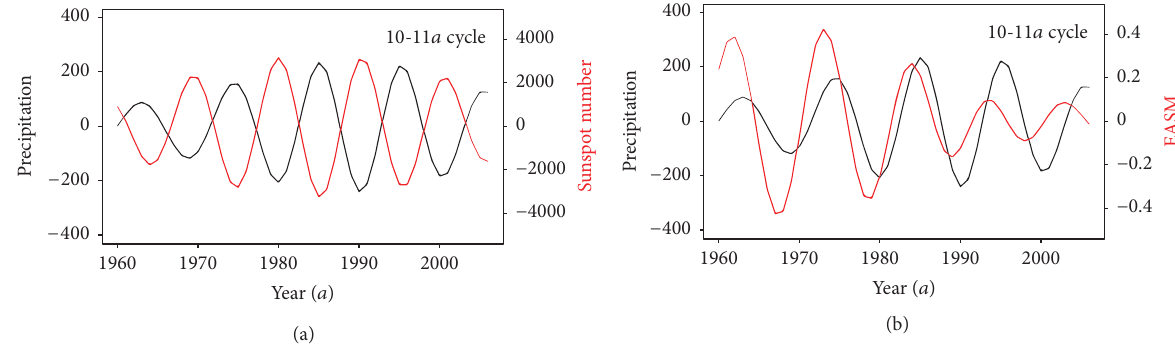
Figure 8: Phase relationship between Liaoning annual precipitation and sunspot number (a), Liaoning annual precipitation and East Asian Summer Monsoon (EASM) (b) at a 10-11 years time